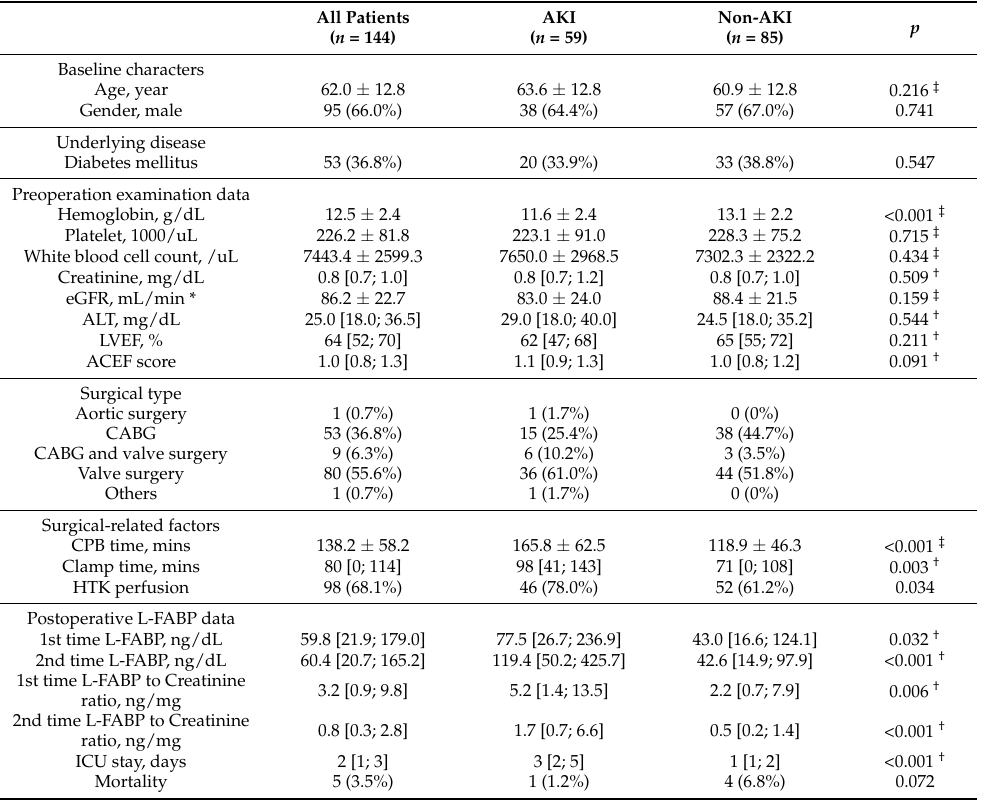
Table 1. Baseline characteristics and outcomes of the patients with AKI after cardiovascular surgery.